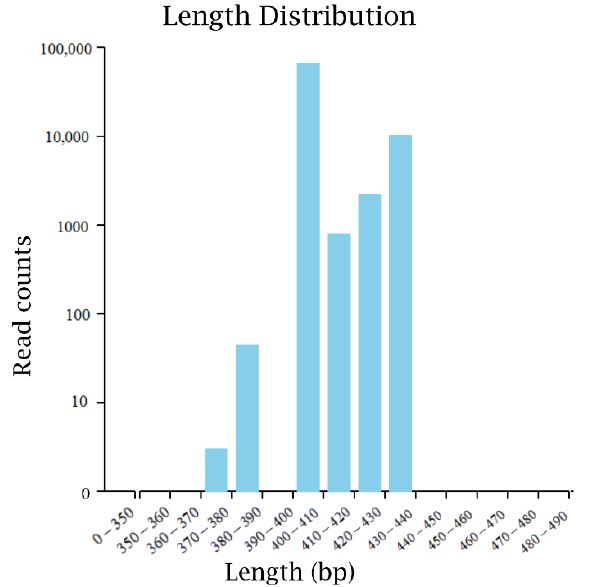
Figure 1. The high-quality sequence distribution of bacteria in the high-through